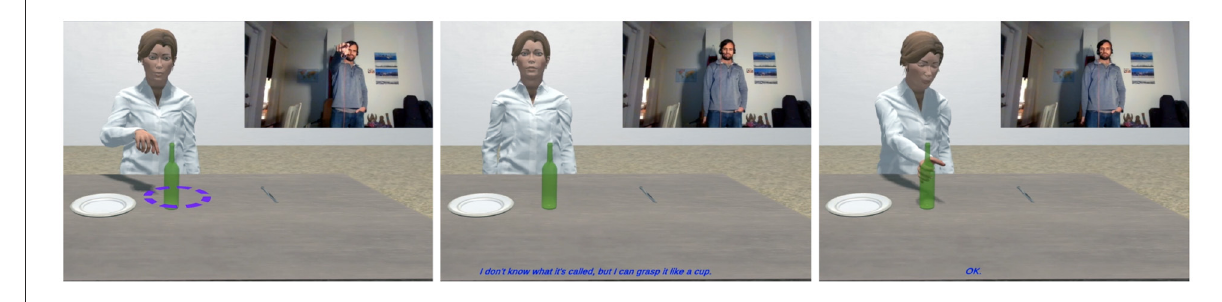
FIGURE6 (1) Human: What is that?; (2) Diana: I don’t know, but I can grasp it like a cup; (3) Human: Grab it. + resultant grasp.